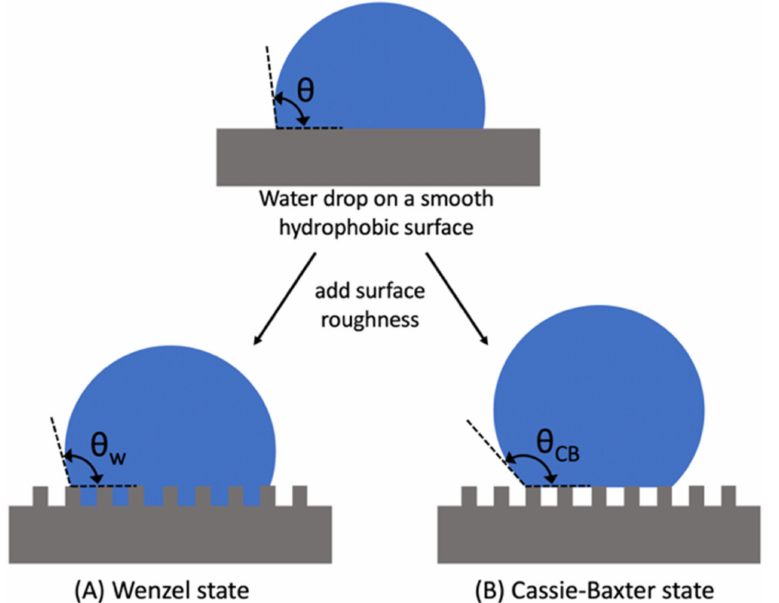
Figure 5. Schematic illustration of how the addition of roughness to a hydrophobic smooth surface can lead to an increase in the static contact angle as predicted by the ( A ) Wenzel; and ( B ) Cassie–Baxter model. The Wenzel model becomes inadequate in describing very rough or porous surfaces since the absolute value of r cos θ may be greater than 1. In such instances, the Cassie–Baxter model [27] is more applicable. In this model, wetting occurs on a porous heterogeneous surface as shown in Figure 5B. The water droplet does not penetrate the grooves but rests on the top of asperities thus maintaining air pockets between the solid phase and the liquid phase. The apparent contact angle is given by